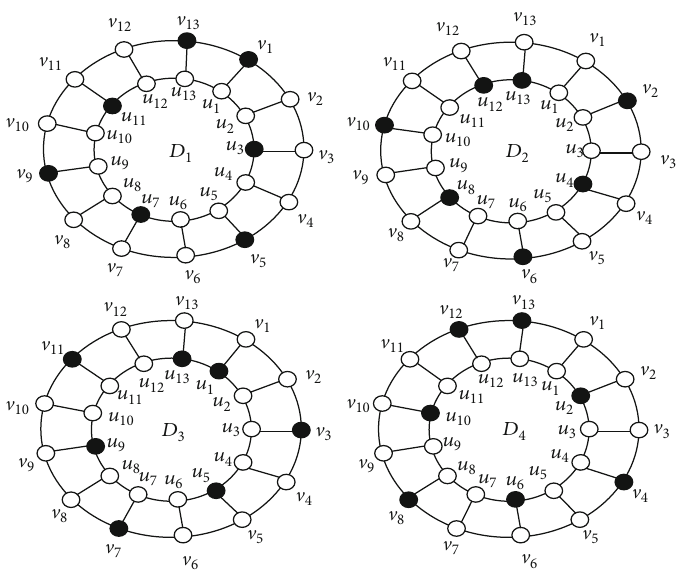
P ð 13, 1 ÞÞ = γ ð P ð 13, 1 ÞÞ = 7 Figure 2: γ ∞ m ð